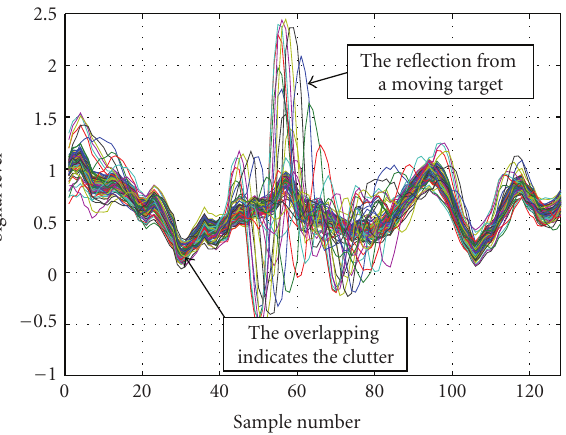
Figure 5: 100 consecutive measurements of a moving metal plate (225 × 500mm 2 ) in the presence of clutter. The overlapping part represents the clutter map (cid:13) r i e , and the pulses di ff erent from the overlapping part indicate the target signals r i t